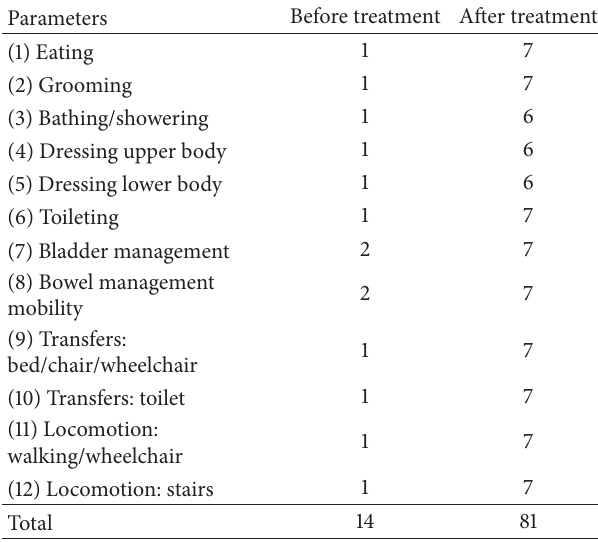
Table 2: Evaluation of self-care, sphincters, and mobility by func- tional independence measure